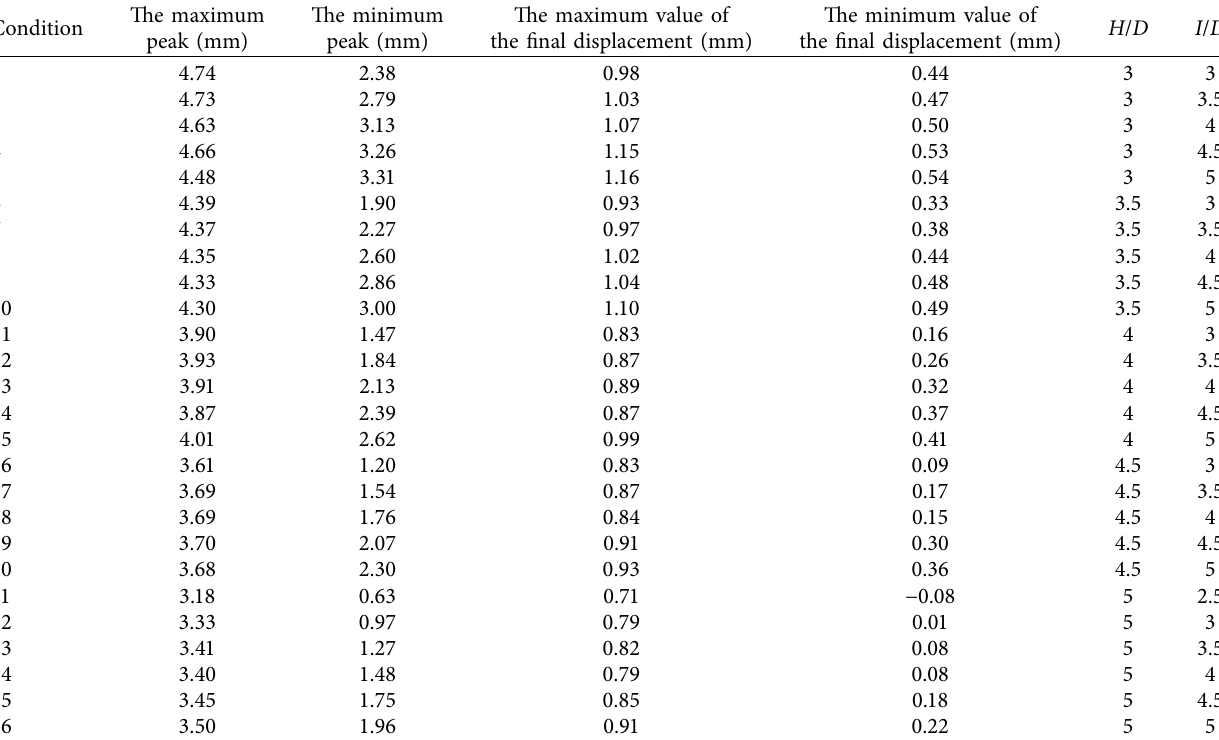
Table 5: Statistics of lateral displacement of each